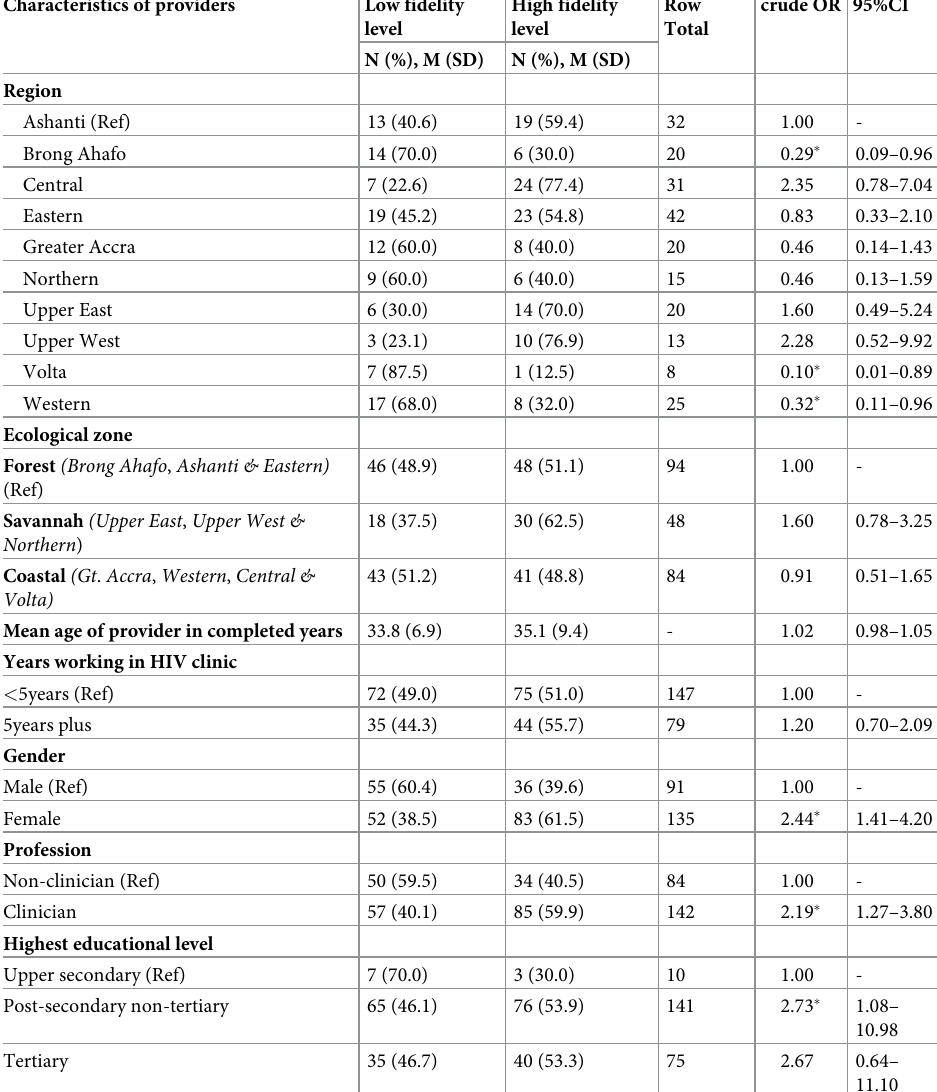
Table 5. Comparison of geographical and provider characteristics between fidelity